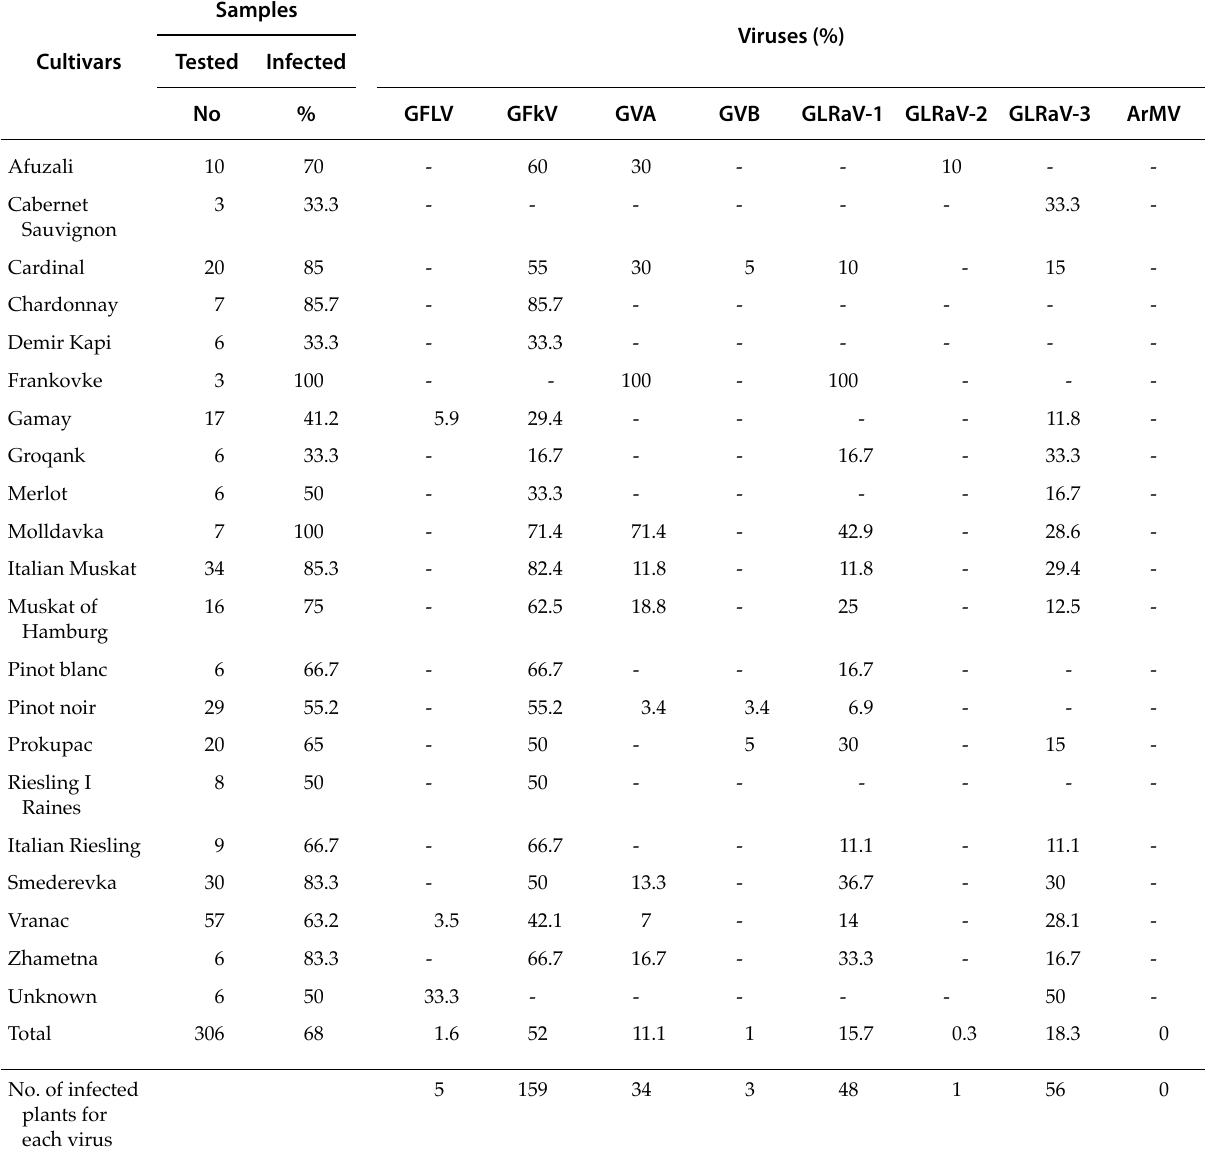
Table 1. Viruses detected by ELISA in the main grapevine varieties grown in Kosovo.